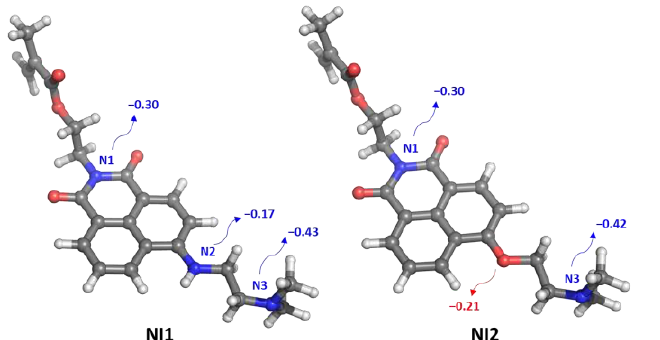
Figure 7. B3LYP-optimized structures of NI1 and NI2. Hirshfeld charges on selected atoms were calculated for NI1 and NI2.